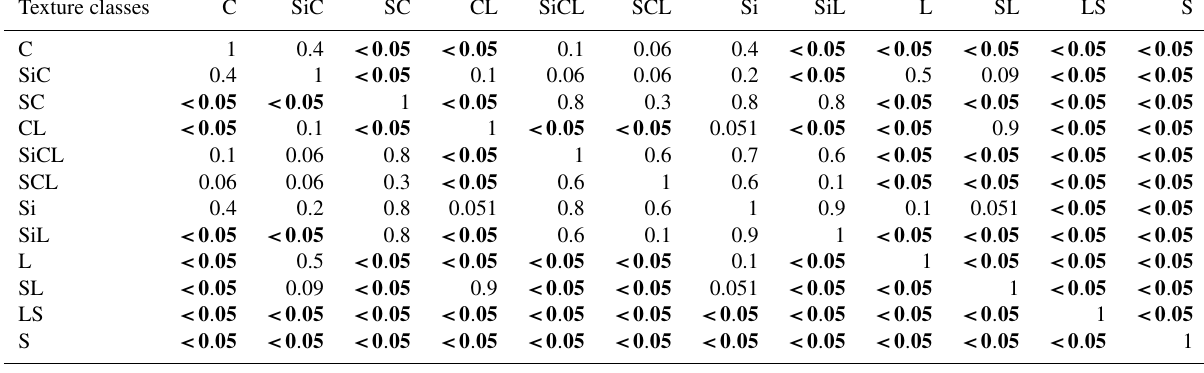
Table A2. Listed p values under 95% confidence interval for each class to show the significant difference in K sat between texture classes for Fig. 3d. The significant difference was computed using ANOVA (analysis of variance) with post hoc Tukey’s HSD (honestly significant difference) test. The values in bold show the significant difference in K sat between two soil texture classes.